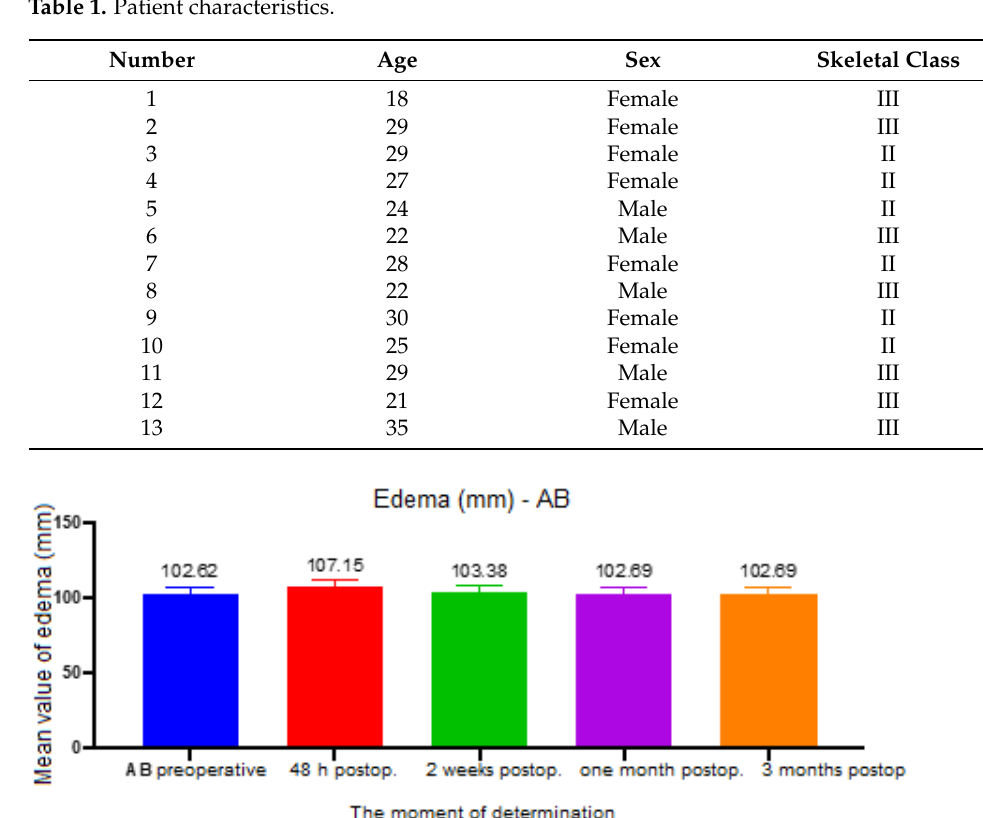
Table 1. Patient characteristics.